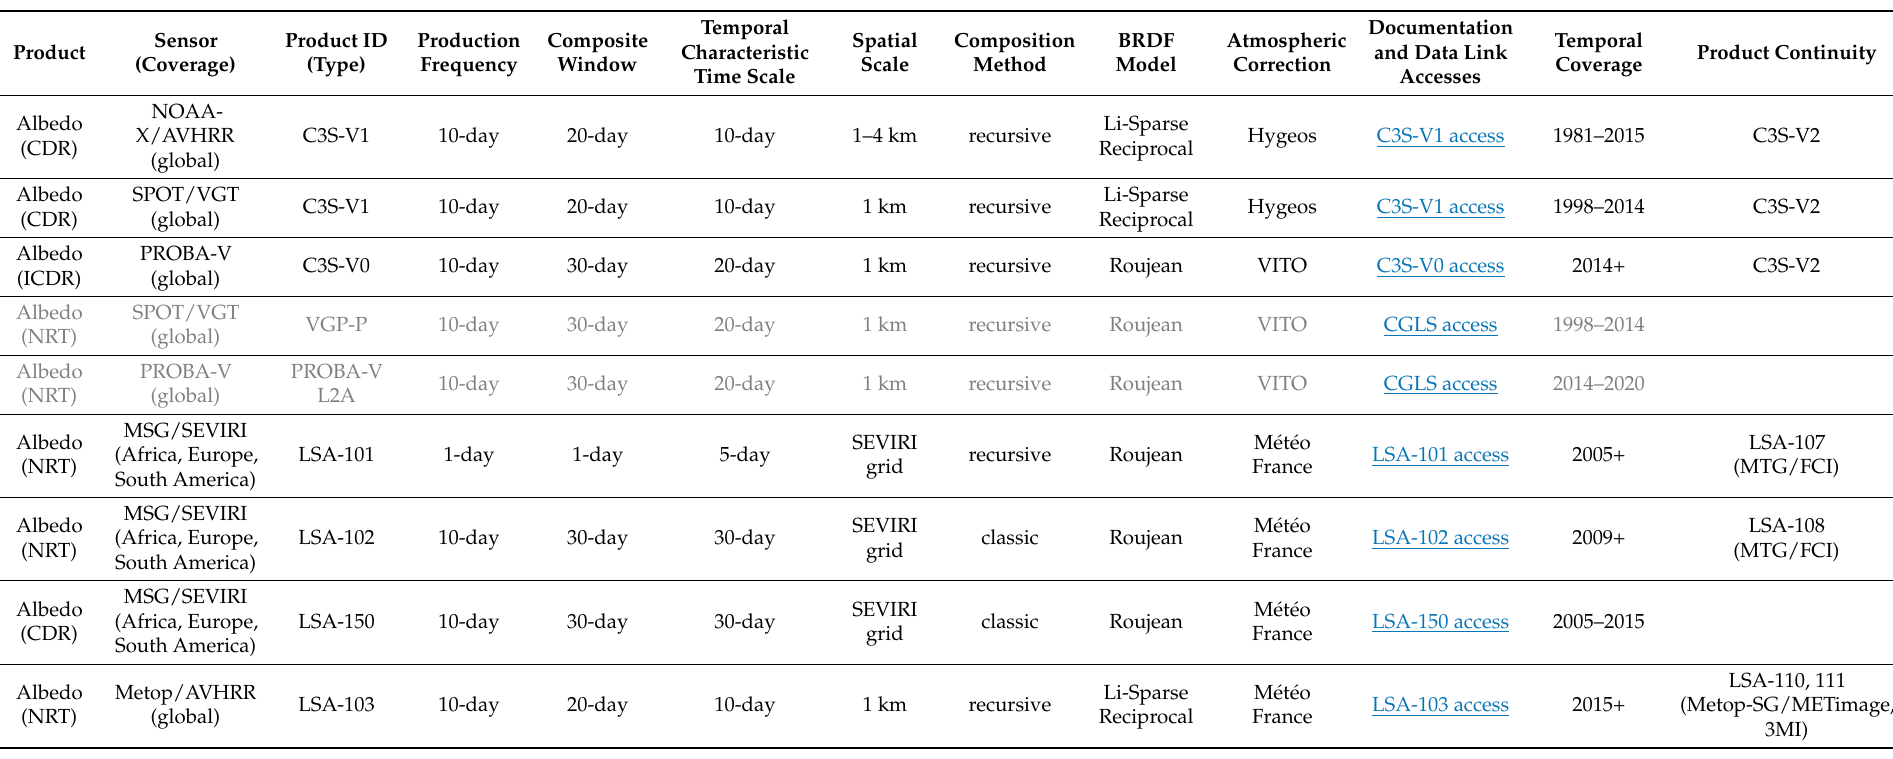
Table 1. List of the operational albedo products developed by the M é t é o France research laboratory. LSA SAF (Satellite Application Facility on Land Surface Analysis) albedo (referred as LSA in the Table) are disseminated in NRT (near real-time) (3 h after the last observation at 00UTC). The timeliness will be reduced in 2021 to 1 h. C3S (Copernicus Climate Change Service) (referenced as C3S in the Table) are reprocessing. CGLS (Copernicus Global Land Service) product, which were under responsibility of M é t é o France and not still maintained, are in grey colour. PROBA-V product from CGLS was reused for the generation of C3S-V0 ICDR Interim Climate Data Record). In 2021, the C3S-V2 and LSA-107 and 108 will complete this